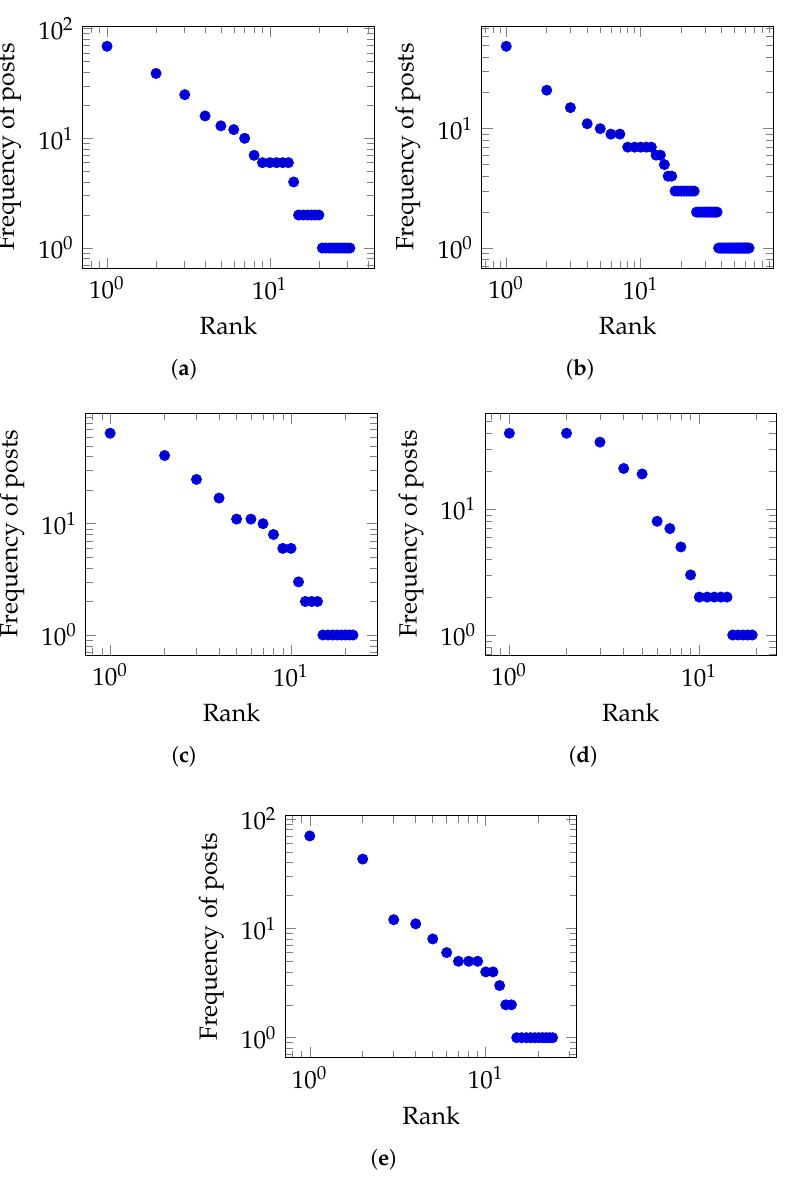
Figure 1. Rank–Size plot. ( a ) Wealth Redistribution dataset; ( b ) Budget-Minded dataset; ( c ) Healthcare dataset; ( d ) Life Insurance dataset; ( e ) First Real Job